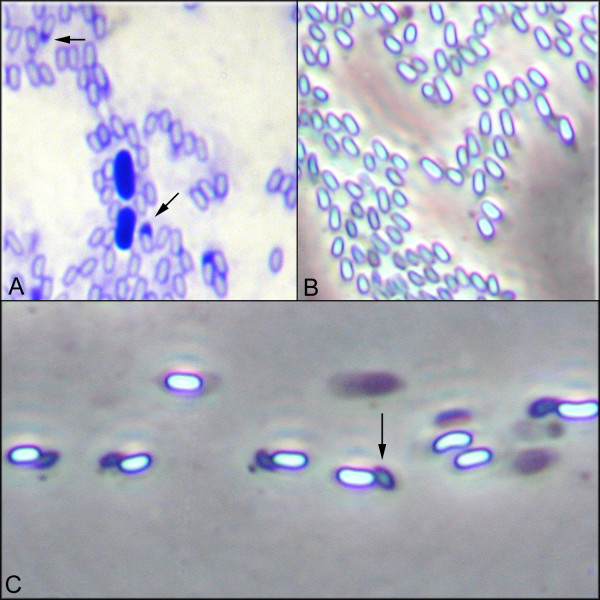
Phase Contrast Microscopy of sporulated cells of Bt1-33. A) stained preparation of Bt1-33 viewed under Brightfield microscopy, 100x oil immersion, B) Bt1-33 viewed under Phase Contrast microscopy, 100x oil immersion, C) Heat-treated preparation of Bt1-33 showing phase-dark crystals lying slightly lateral and terminal to the spore, Phase Contrast microscopy, 100x oil immersion.